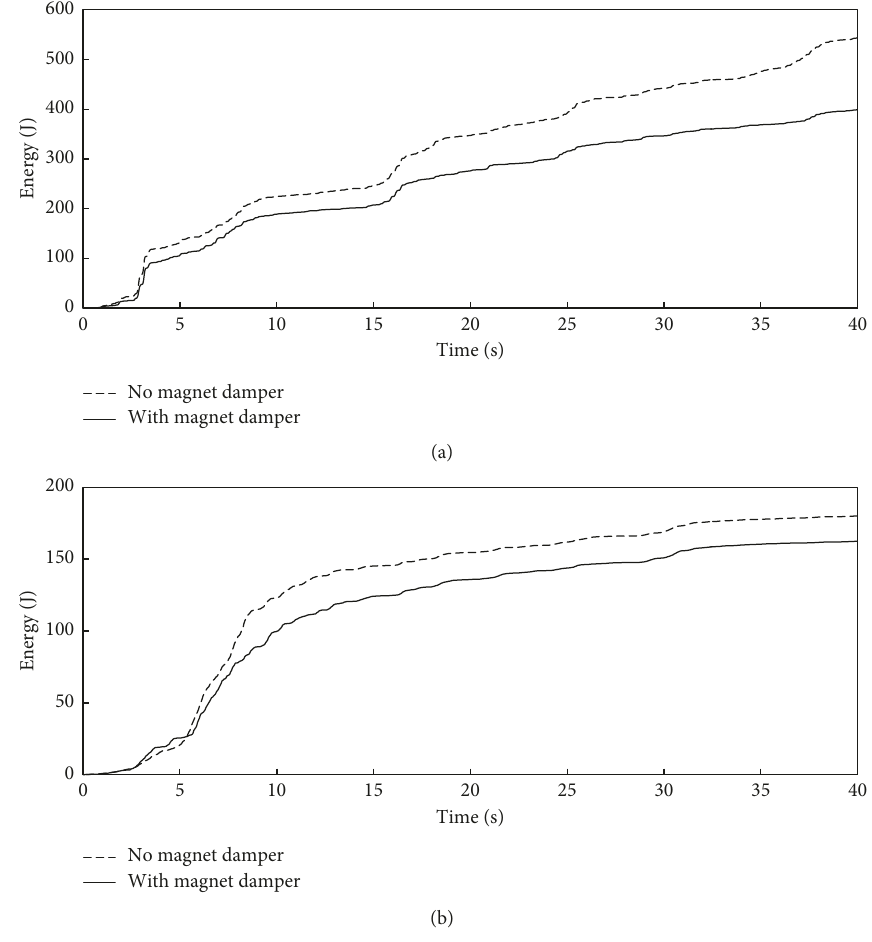
Figure 17: Cumulative energy dissipation for two seismic waves. Cumulative energy dissipation for the (a) El-Centro NS seismic wave excitation and (b) Taft EW seismic wave excitation.